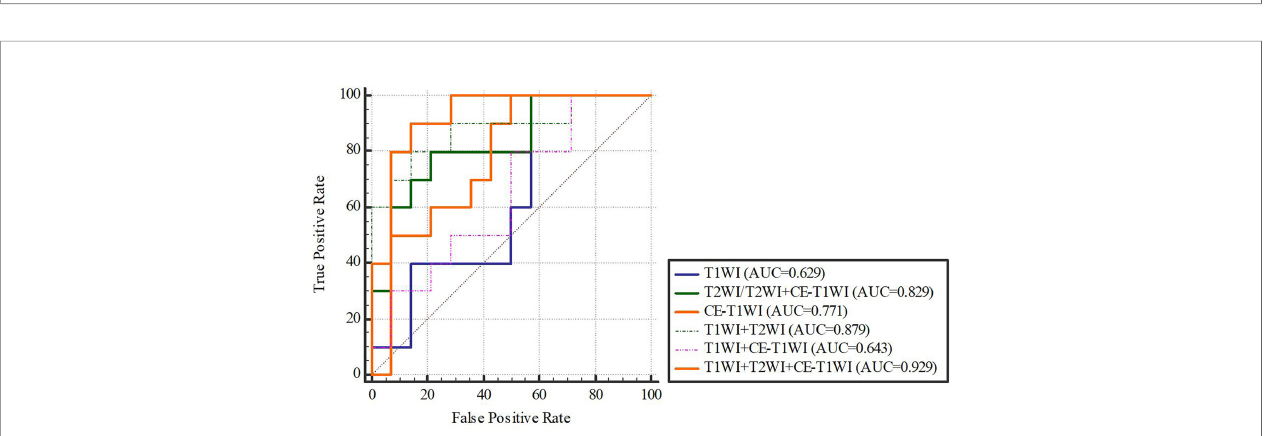
FIGURE 6 | SVM-classi fi er in the training cohort.